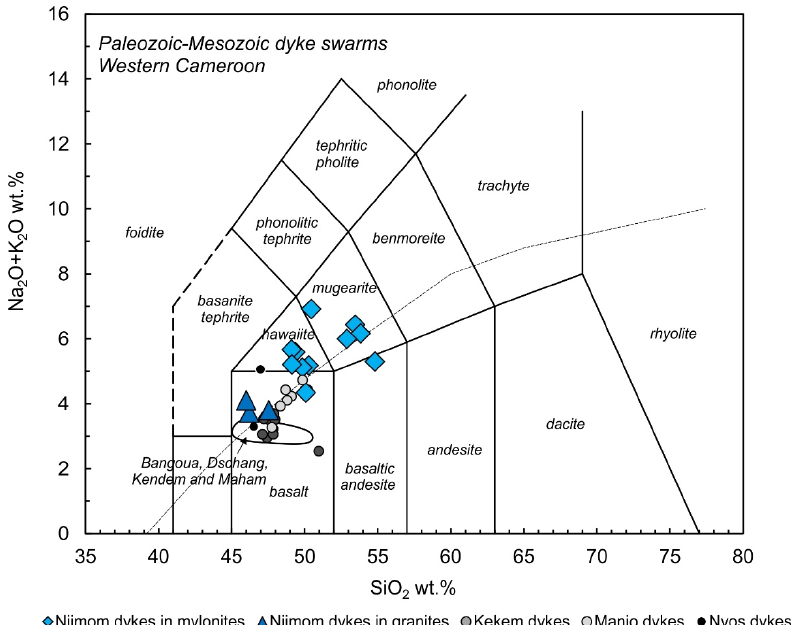
Figure 8. TAS classification diagram [18] for the Njimom dykes. The subalkaline-alkaline line is from [22]. Data of mafic dykes (Bangoua, Dschang, Maham, and Kendem) are from [7], Kekem dykes from [5], Manjo dykes from [6], Nyos dykes from